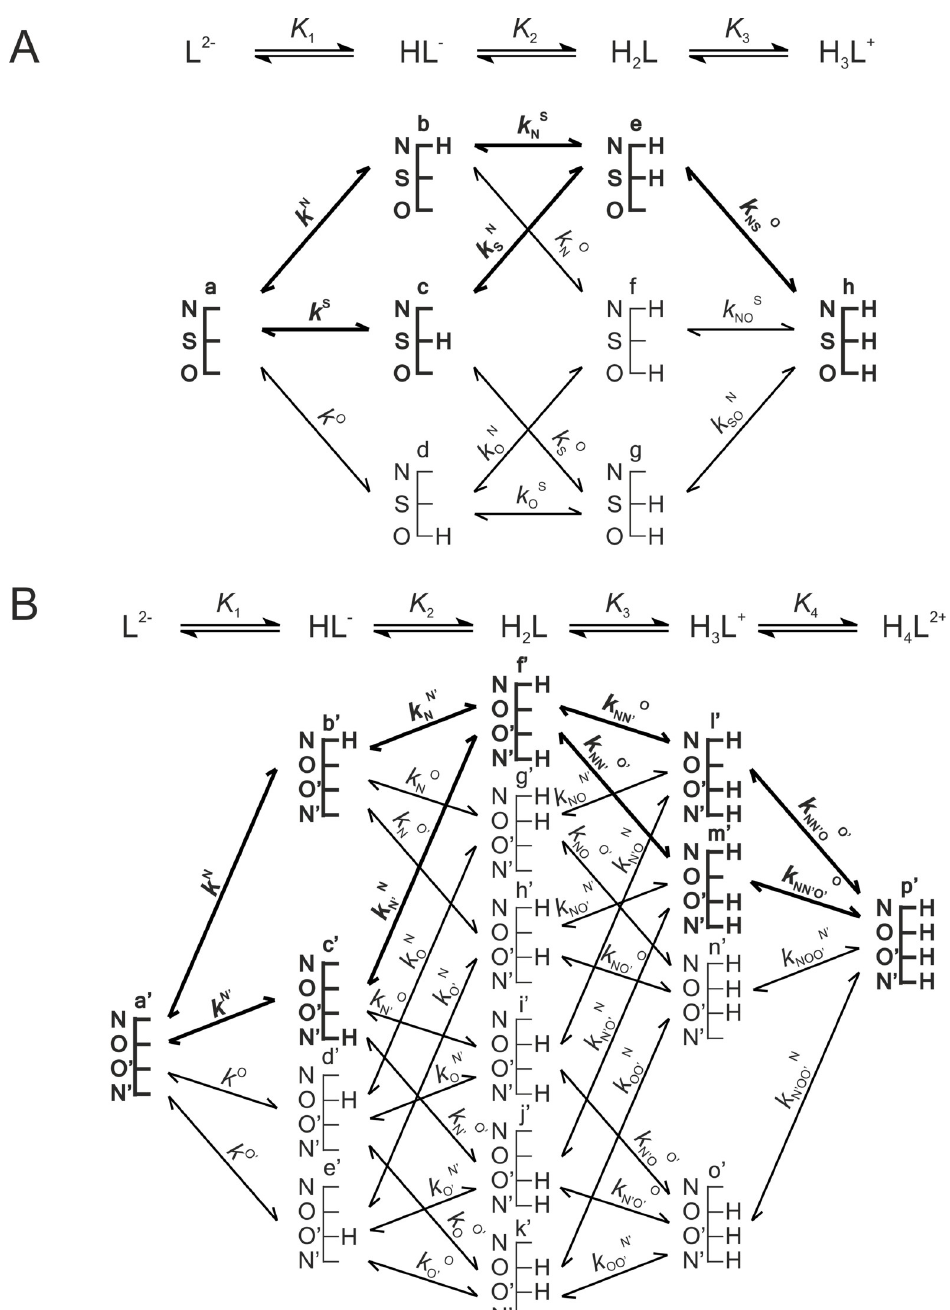
Fig 1. This figure was reproduced from [6, 10]. In this figure the protonation equilibrium schemes of cysteine Cys (A) and cystine (Cys) 2 (B) are depicted. Stepwise macroscopic protonation constants ( K 1 , K 2 , K 3 ... ) characterize overall protonation state of the compounds, where L 2 − , HL − , etc. are the successively protonating ligands. In the schematic networks the species-specific protonation pathways are depicted in terms of microspecies (a, b, c ... ) and microscopic protonation constants ( k N , k N S ... ) that characterize the submolecular localization of the protonation within the molecule. The components of the major pathways are in bold; these microspecies have orders of magnitude larger relative abundance among their protonation isomers. Symbols N, S, and O represent the amino, thiolate, and carboxylate basic moieties,